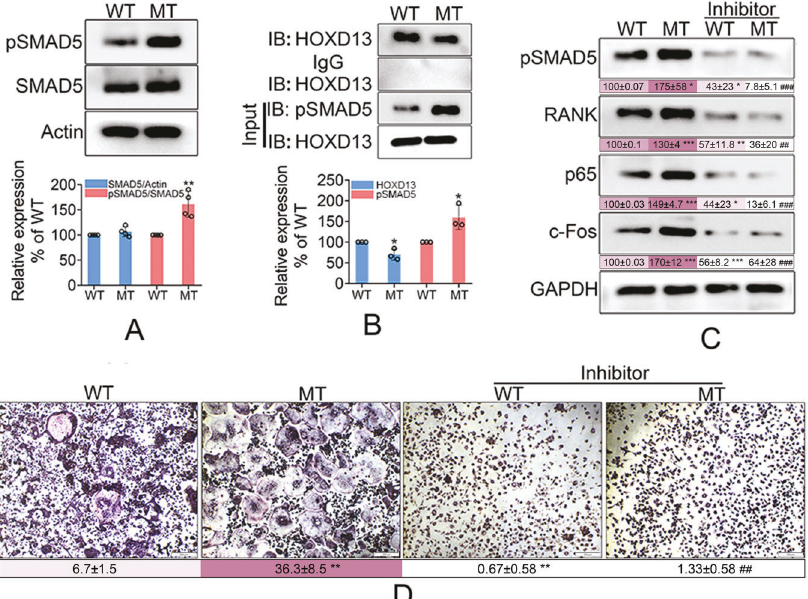
Fig. 5 The Hoxd13 mutation increased the expression of Rank, c-Fos, and phosphorylated p65 by releasing pSmad5. A The effect of Hoxd13 mutation on the expression and phosphorylation of Smad5 (pSmad5). ** p < 0.01. B The effect of Hoxd13 mutation on the interaction between HOXD13 and pSmad5. * p < 0.05. C The bone marrow monocytes from wild and mutant mice were treated with 1200 nM dorsomorphin, and were then exposed to M-CSF and RANKL for 5 days. Western blot was performed to determine the expression of pSmad5, Rank, p65, and c-Fos. * p < 0.05; ** p < 0.01; *** p < 0.001; ## p < 0.01 vs MT groups; ### p < 0.001 vs MT groups. D TRAP staining was performed to determine the osteoclast differentiation. ** p < 0.01; ## p < 0.01 vs MT groups. All experiments were repeated three times.